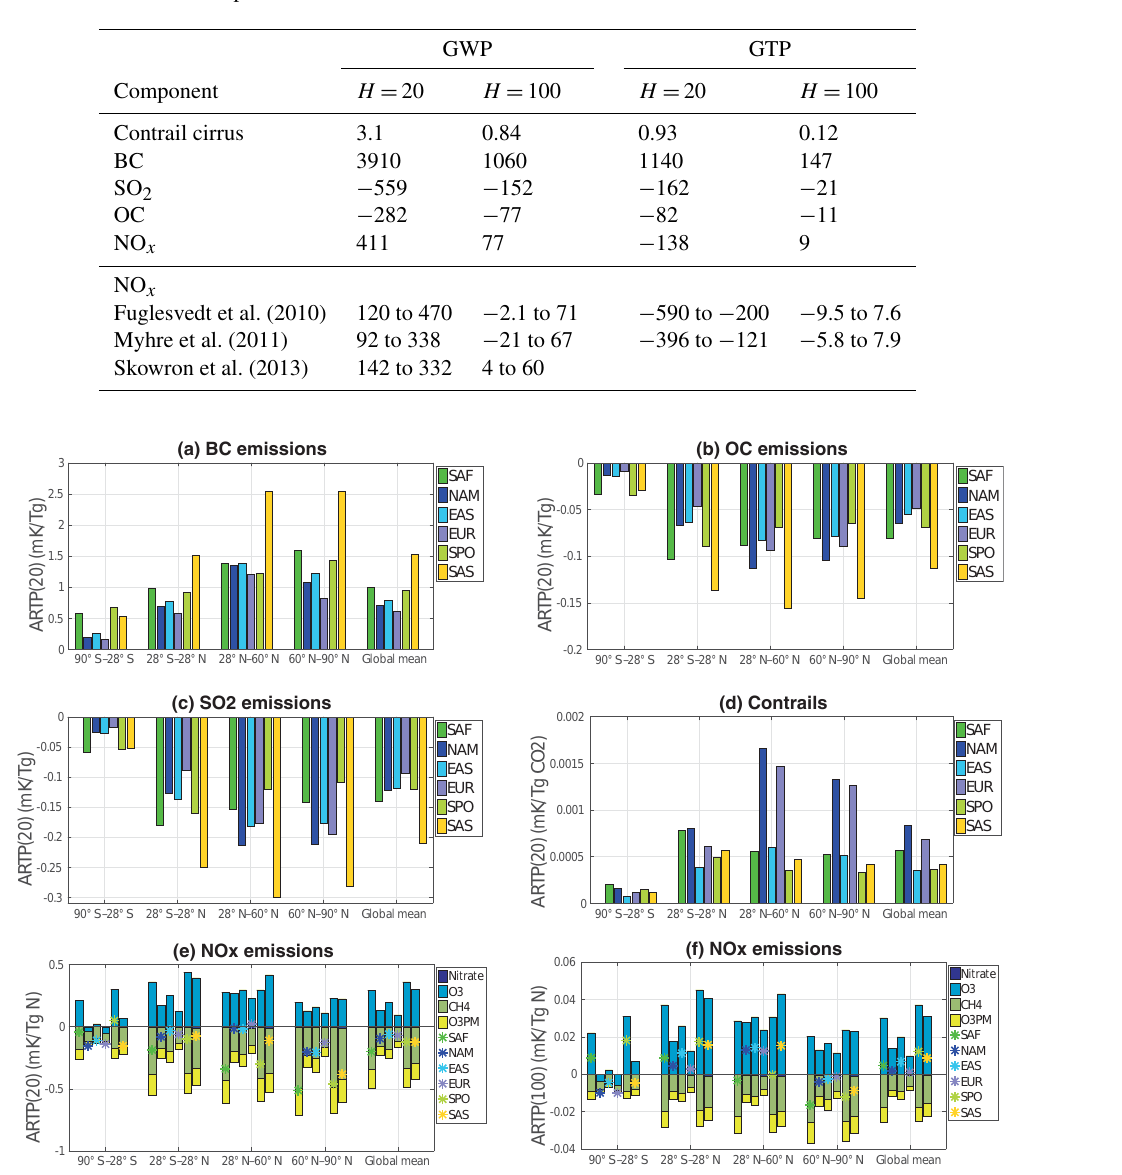
Figure 2. ARTP(20) of aviation (a) BC, (b) OC, (c) SO 2 and (d) contrail cirrus, and (e, f) ARTP(20) and ARTP(100) of aviation NO x . The asterisks in (e) and (f) show the net NO x effect of emissions in each source region, while the colored bars give the contributions from ozone production (O 3 ), NO x -induced methane loss (CH 4 ) (including subsequent stratospheric water vapor loss), methane-induced ozone changes (O 3 PM) and NO x -induced nitrate